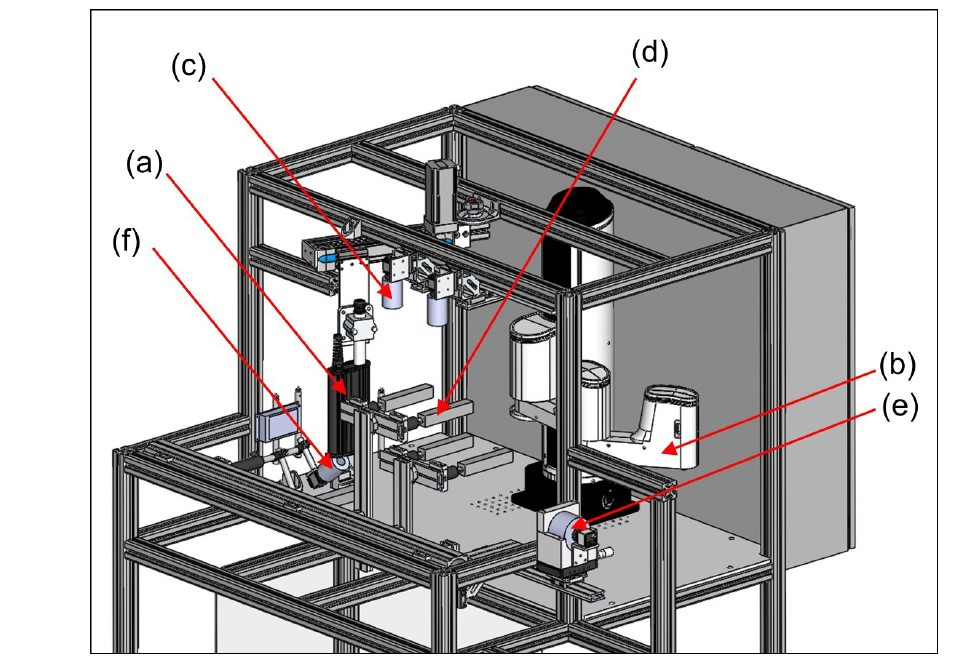
Figure 2. CAD model of the test bench comprising of the following components: (a) printhead, (b) pick-and-place robot for metal test sheets, (c) fluorescence and colour cameras for quality control, (d) industrial LED lighting equipment (Top-Line-D2, Büchner GmbH) to ensure a constant image quality by providing uniform illumination and minimizing unwanted reflections on the metal sheets’ surfaces, (e) camera to document drop ejection and the formation of satellite droplets, and (f) camera to observe ink residues on the nozzles on the bottom of the printhead. The metal sheets as well as input and output tray are not shown for clarity.